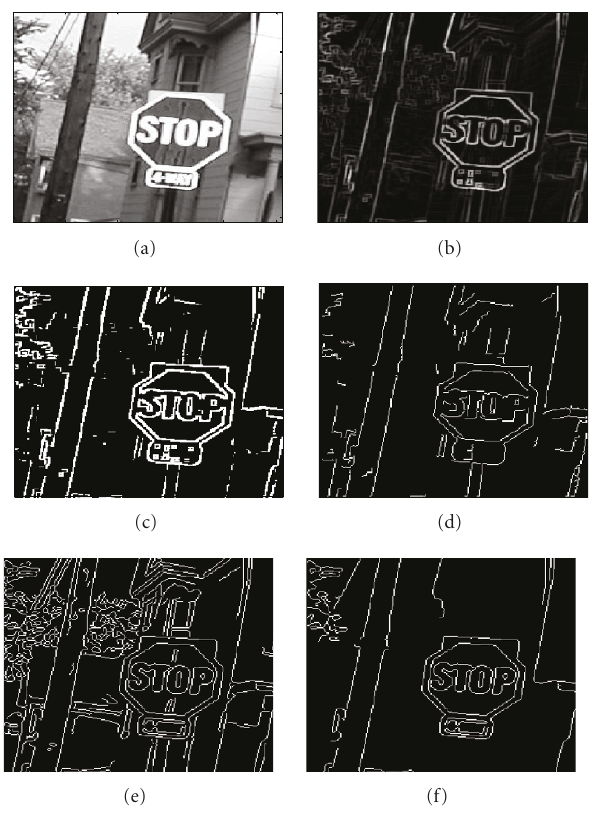
Figure 2: (a) Intensity image, (b) morphological edge strength image, (c) morphological edge after thresholding, (d) final edge image after thinning, (e) Canny edge image for a low threshold and (f) Canny edge image for a high